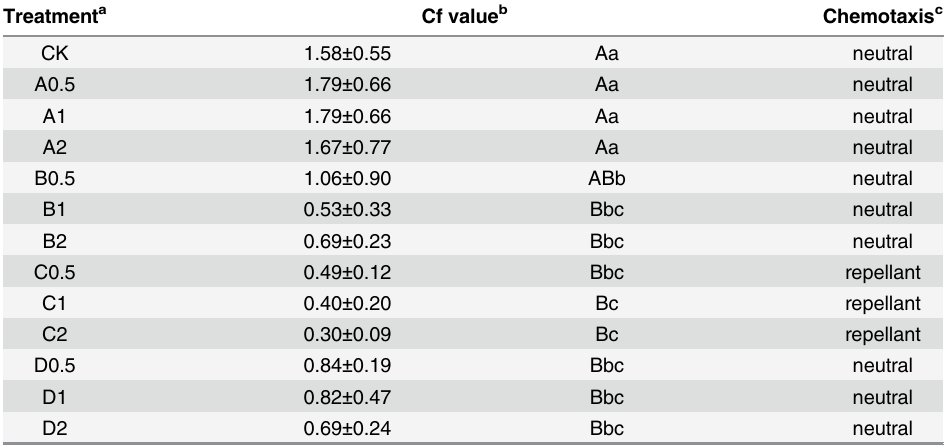
Table 3. Effects of four simulated components on chemotaxis of M . incognita J2 at WA plate. Treatment